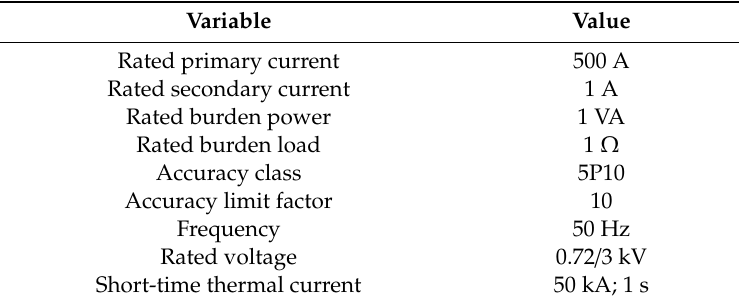
Table 1. Current transformers characteristics.